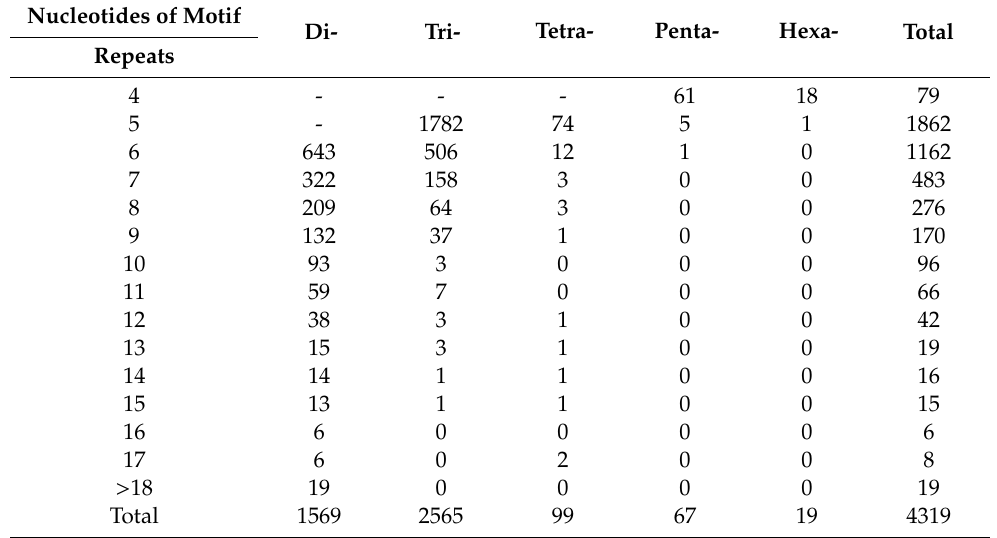
Table 6. Distribution of Single Sequence Repeats (SSRs) based on the number of repeat motifs. Nucleotides of